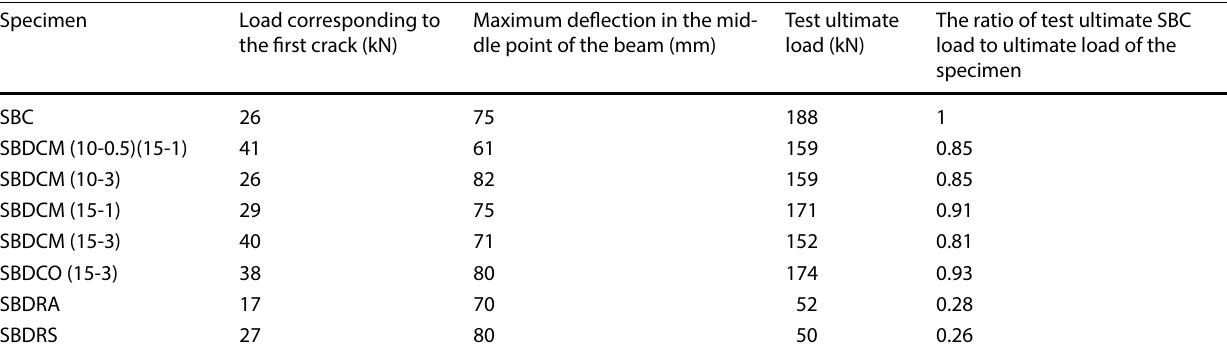
Test ultimate load